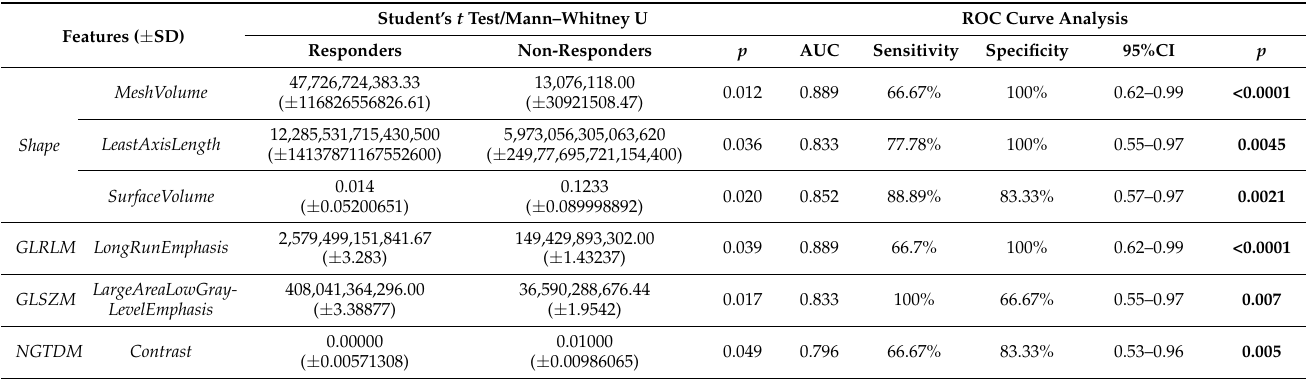
Figure 3. Significant receiver operating characteristic (ROC) curves of the radiomic features extracted from pre-perioperative chemotherapy CT scans. The area under the curve (AUC) and p -value are reported in each ROC curve. The best AUC achieved is represented by Cluster Shade and Autocorrelation . Table 4. ∆ Radiomics analysis between responders and non-responders expressed as a simple comparison analysis (Student’s t test/Mann–Whitney U) and receiver operating characteristic (ROC) curve analysis with the area under the curve (AUC), sensitivity, specificity, and 95% confidence interval